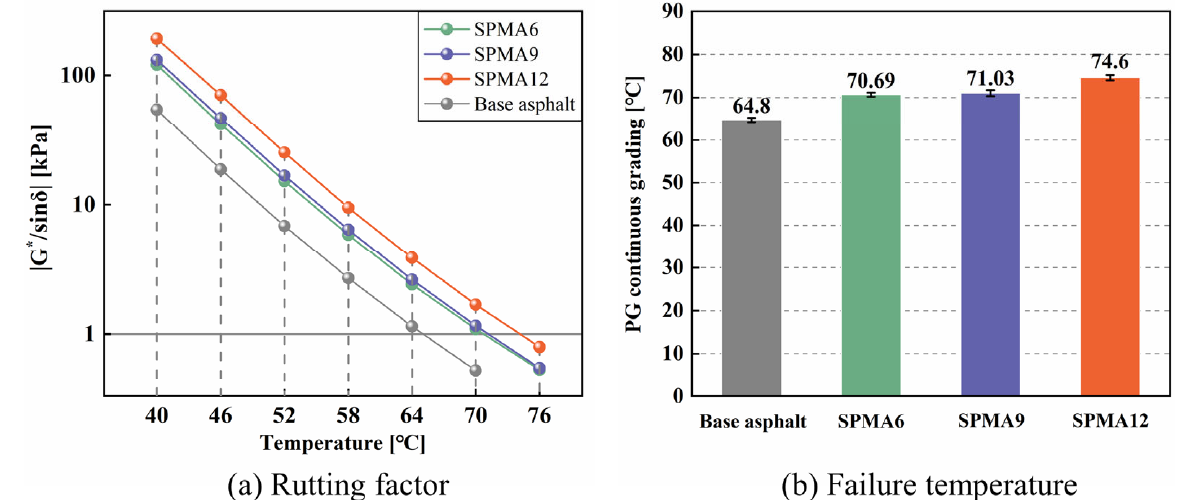
Figure 8. Rutting factor of asphalt binders.